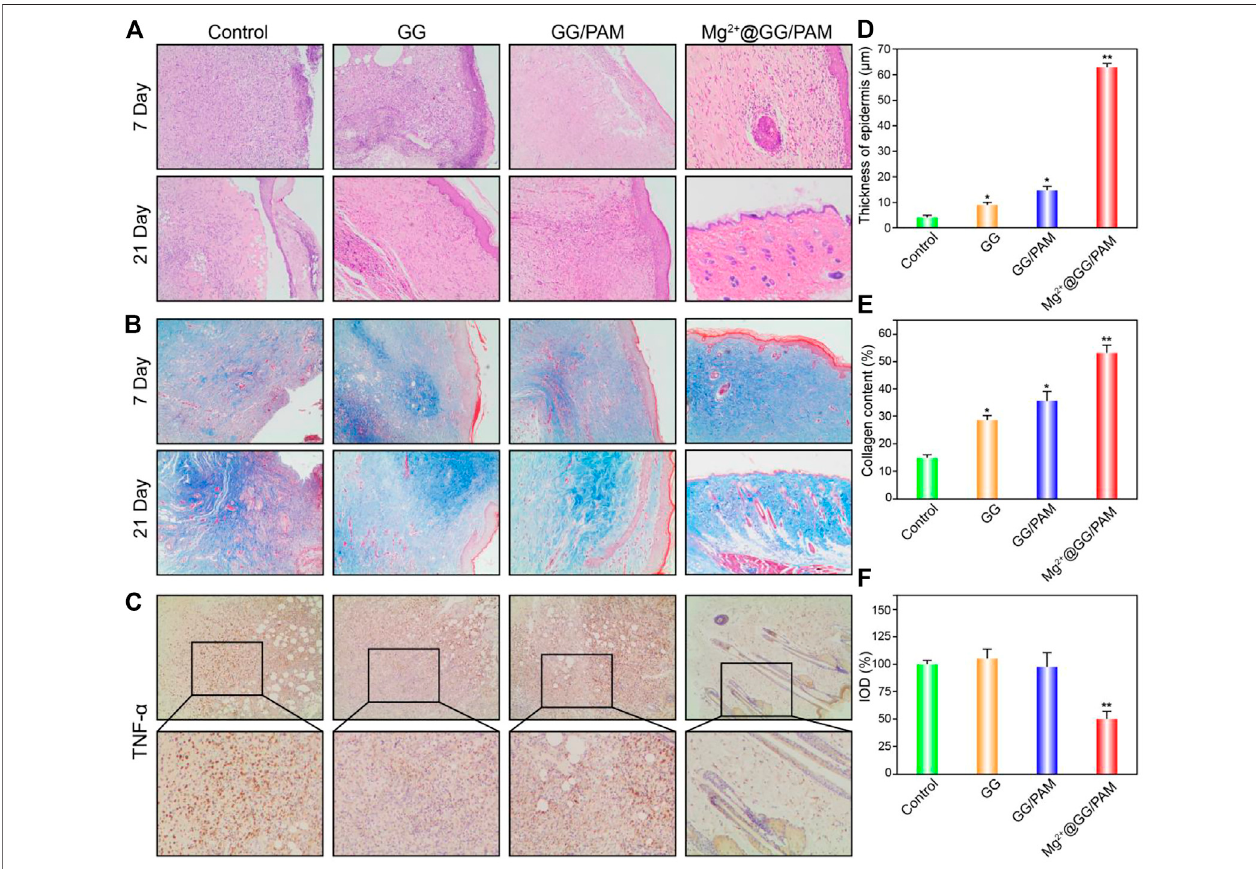
FIGURE 7 | Histological evaluation of the wound at 7 and 21 days using hematoxylin and eosin (HE) staining (A) , Masson ’ s trichrome staining (B) , and TNF- α immunohistochemical staining (C) , thickness of epidermis statistics (D) and collagen content statistics via ImageJ software (E) . Integrated optical density of TNF- α was quanti fi ed on immunohistochemistry slices (F) . The values are represented as mean ± SD ( n (cid:1) 6). * p < 0.05, ** p < 0.01 vs control.